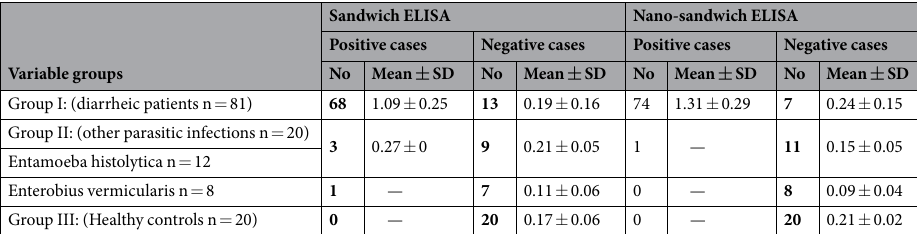
Table 2. Results of sandwich ELISA and nano-sandwich ELISA in diagnosis of G. lamblia .